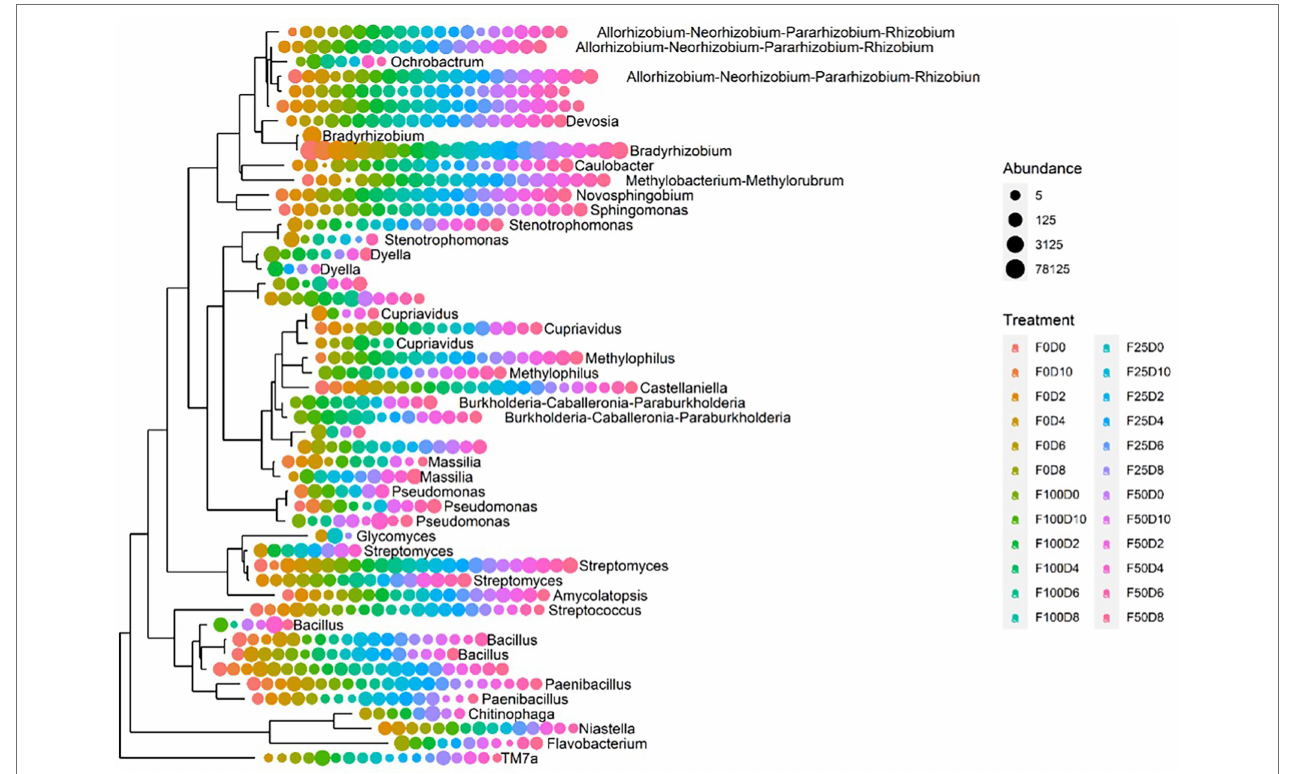
FIGURE 7 | Phylogenetic tree of the 50 most abundant ASVs for all treatments at the genus